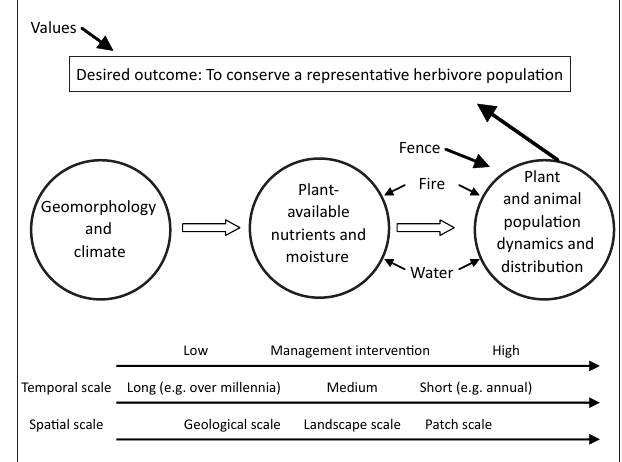
FIGURE 1: A framework illustrating the top-down influences of the herbivore objective as an outcome of the desired state. The herbivore population is influenced by bottom-up processes that effect these populations at different spatial and temporal scales. This determines the options that management has to affect the shorter-term herbivore population outcomes (adapted from Peel, M.J.S., 2005, ‘Towards a predictive understanding of savanna vegetation dynamics in the eastern Lowveld of South Africa: with implications for effective management’, PhD thesis, University of